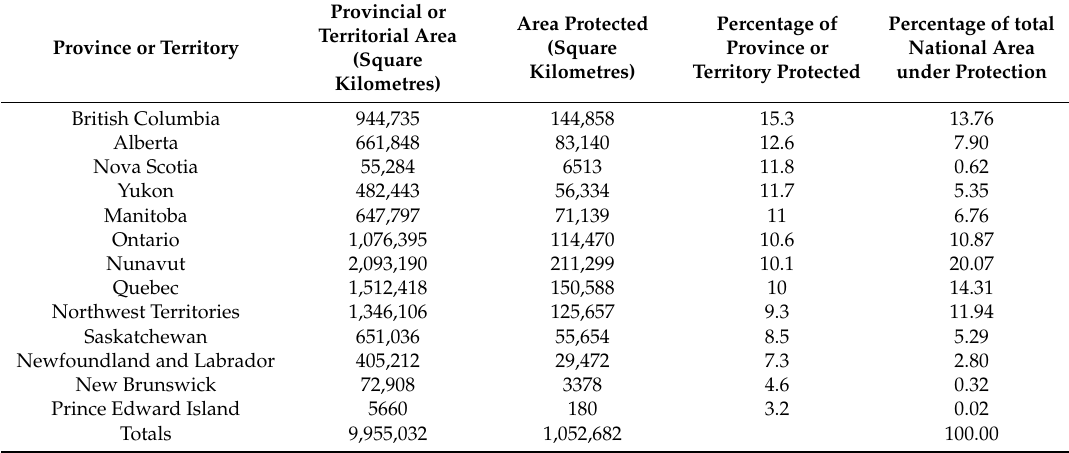
Table 1. Total percentage of terrestrial area protected by province and territory, Canada, 2016. Note that areas reported include land and freshwater, but not marine areas. Also note that not all jurisdictions in Canada report on protected areas that are privately owned.